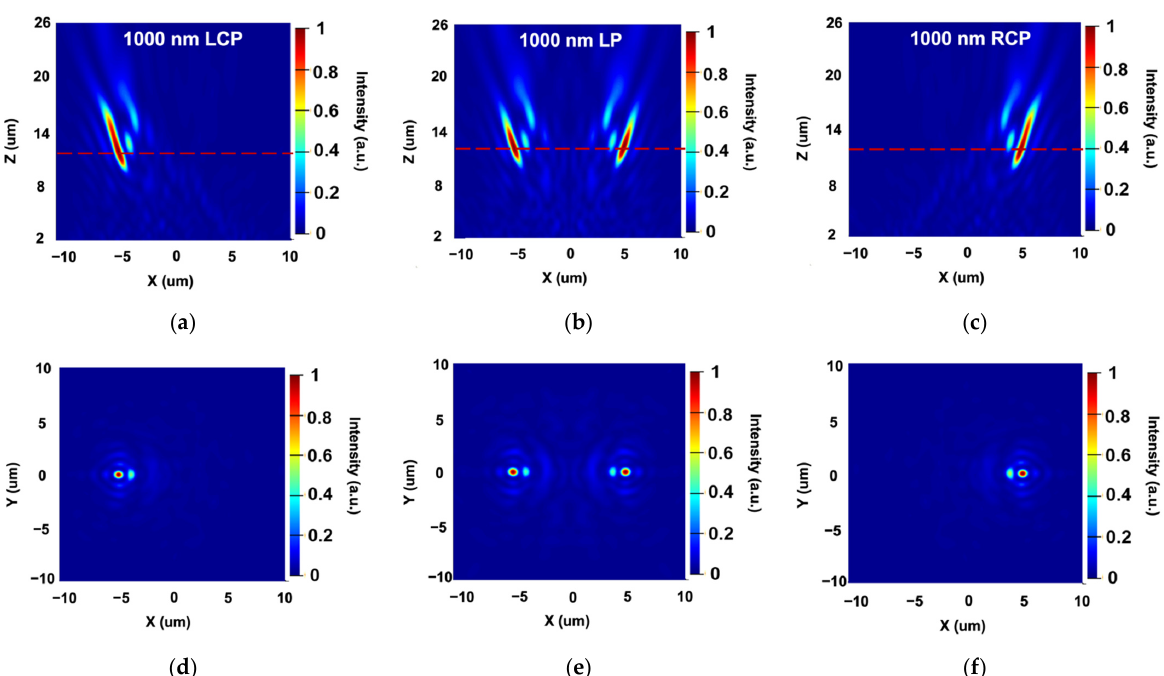
Figure 6. Performance of the dual-wavelength achromatic bifocal metalens at 1000 nm. ( a – c ) Simu- lated optical intensity of the proposed metalens with incident wavelength at the x–z plane when y is 0 for LCP, LP and RCP. ( d – f ) Simulated optical intensity at the x–y plane at the designed focal plane.